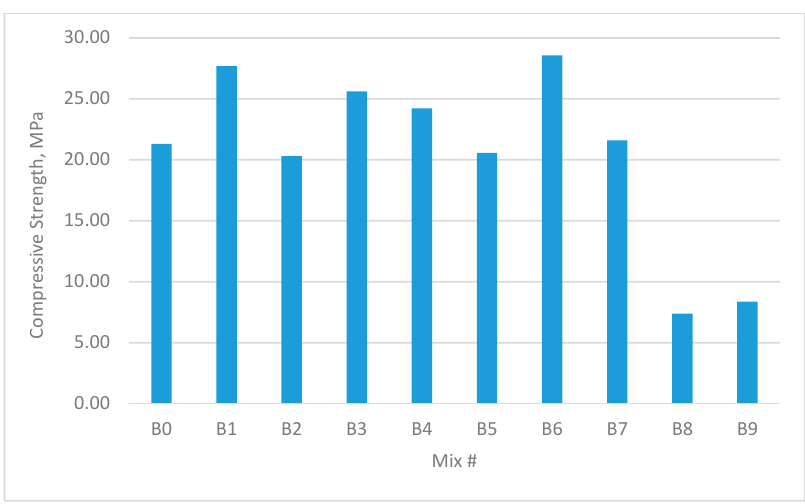
Figure 5. Uniaxial compressive strength of concrete beams with W/B ratio 0.35.